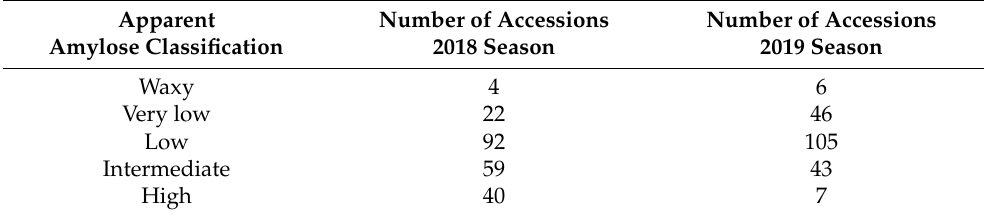
Table 1. Frequency distribution of rice lines based on apparent amylose concentration from pheno- typing in Beaumont, Texas in 2018 and 2019.